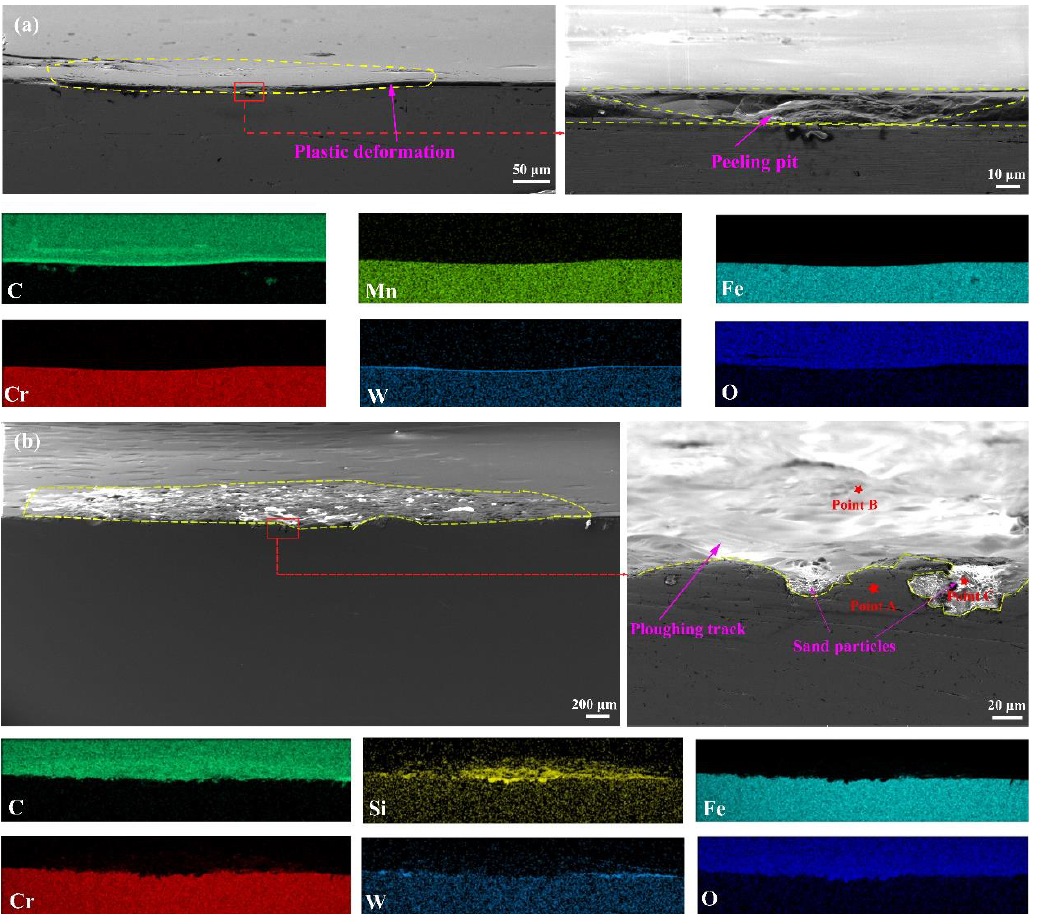
Figure 13. Cross-sectional topography of Cr/W-DLC/DLC multilayer films at 500 °C under ( a ) no-sand condition and ( b ) sand condition. Table 3. Chemical composition at typical position of wear scar (wt. %).